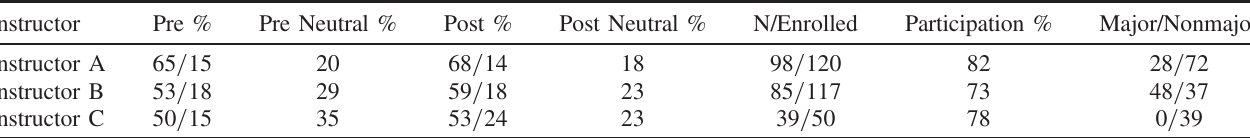
TABLE II. Average Pre-Post MPEX scores for three instructors. MPEX scores are given as FAV/UNFAV.